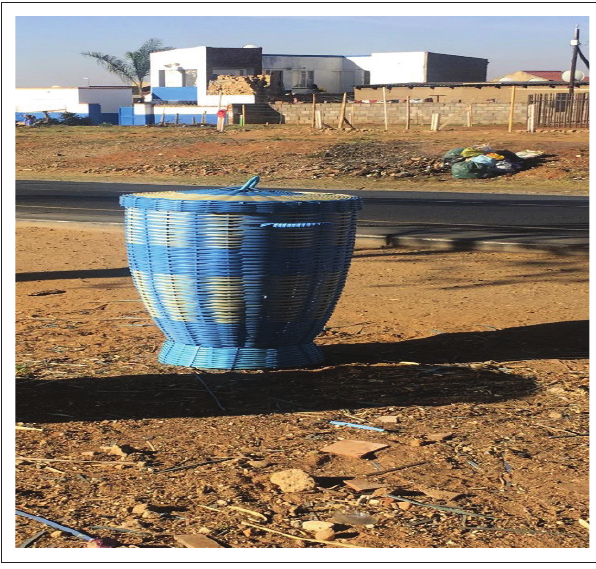
Source : Photo taken by the author. FIGURE 2: Laundry baskets made from drainage pipes sold by